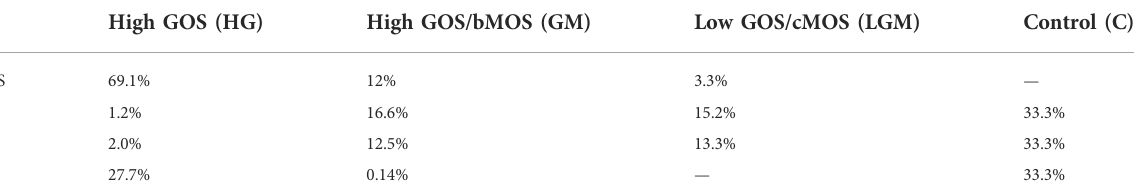
TABLE 1 Overview of the different oligosaccharide